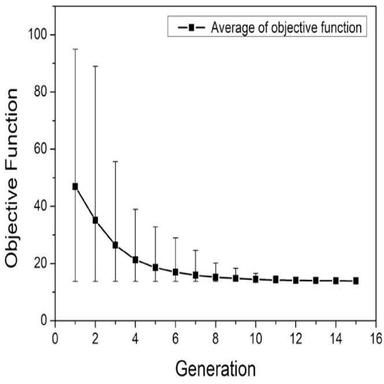
Total objective function by increasing the number of generation.